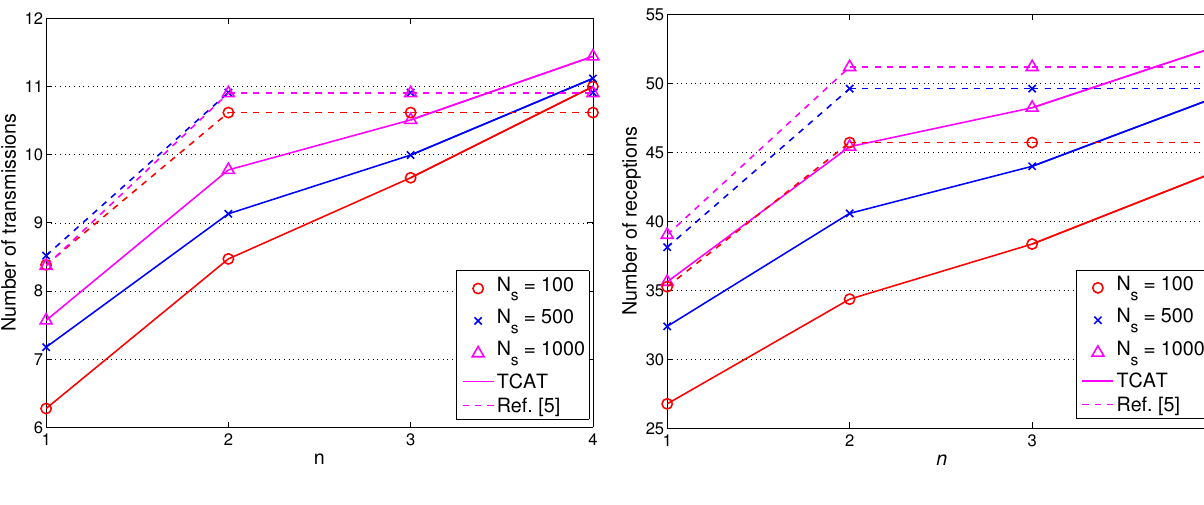
Figure 18. The comparison of accumulated network energy